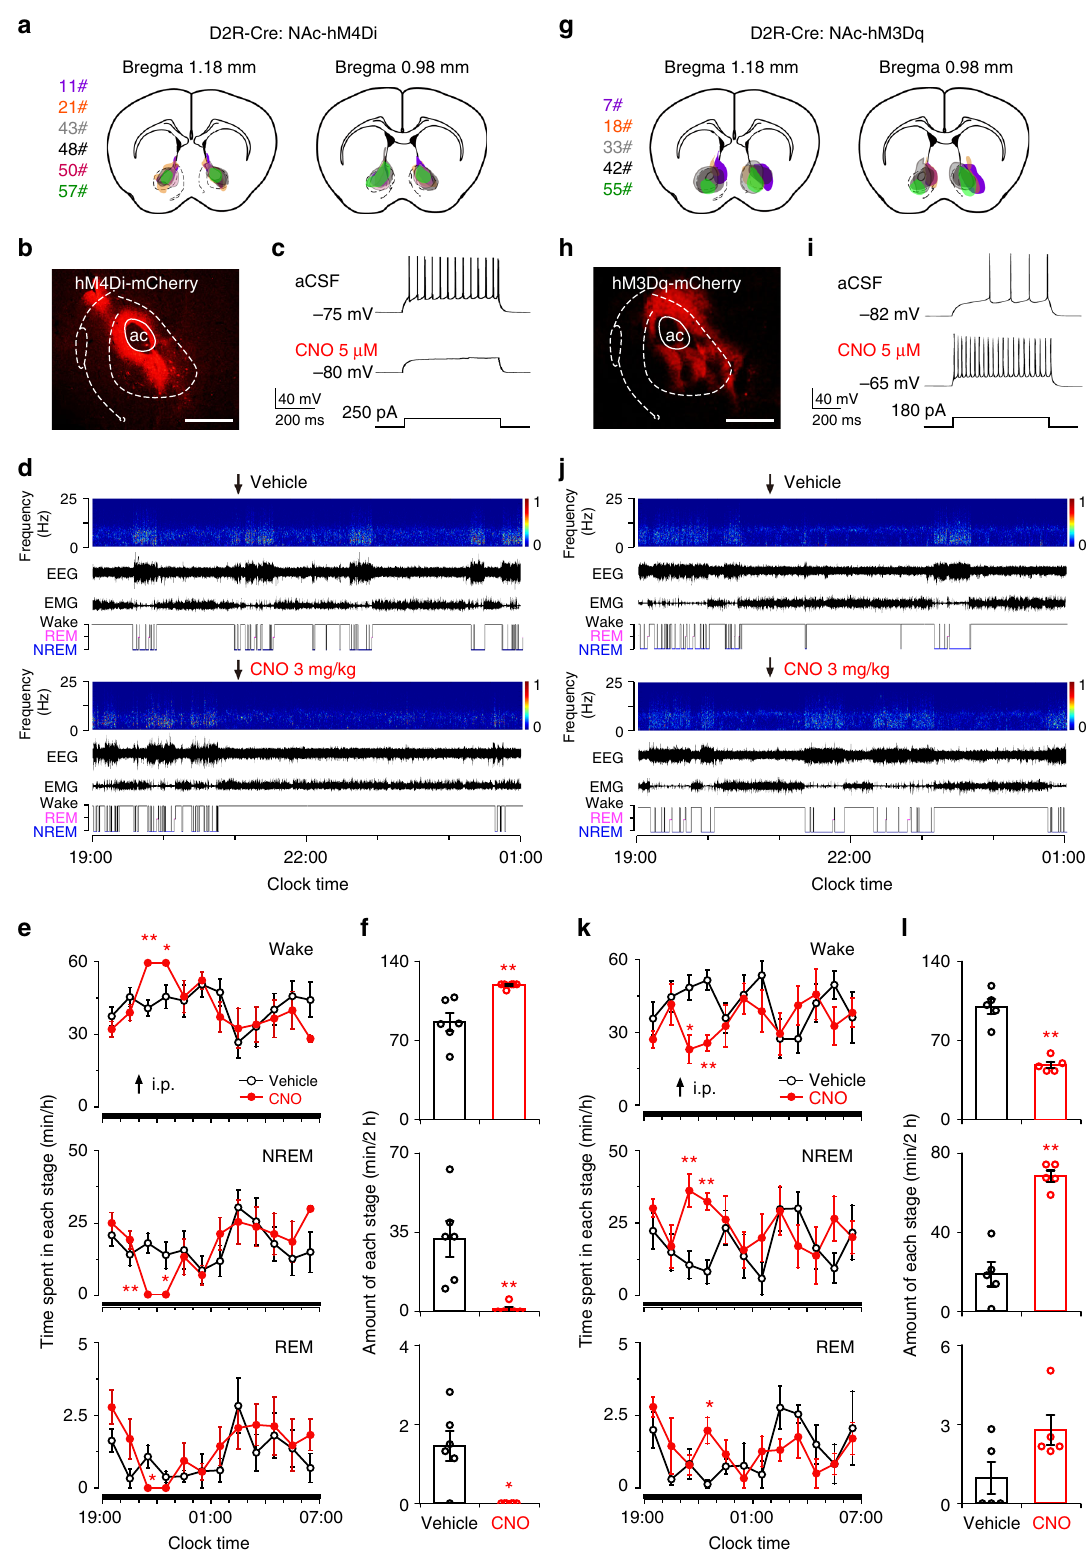
Stereotaxic surgery . All mice used were anesthetized with pentobarbital sodium (50 mg/kg, i.p.) for surgical procedures and placed into a stereotactic frame (RWD, Shenzhen, China). A burr hole was made, and a fi ne glass pipette (15 – 20 µm tip) containing recombinant AAV-DREADD, AAV-ChR2, or AAV-mCherry virus was inserted bilaterally into the NAc (anteroposterior (AP) = + 1.4mm, mediolateral (ML) = ± 1.0mm, dorsoventral (DV) = − 3.8mm). A total of 70 – 100 nL virus